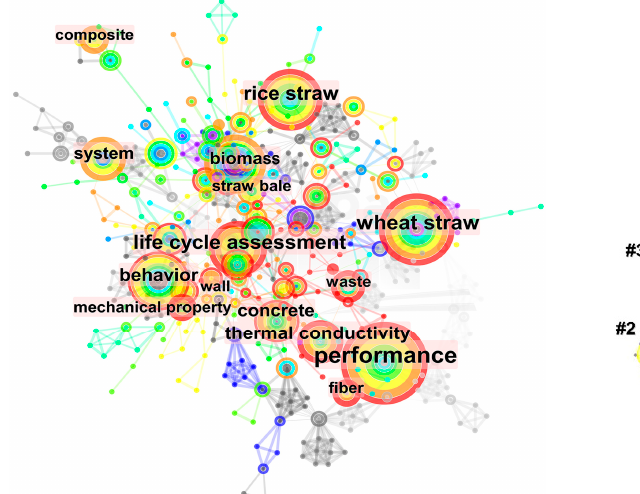
Figure 6. ( a ) Keyword co-occurrence network; ( b ) keyword clustering analysis pro fi le.